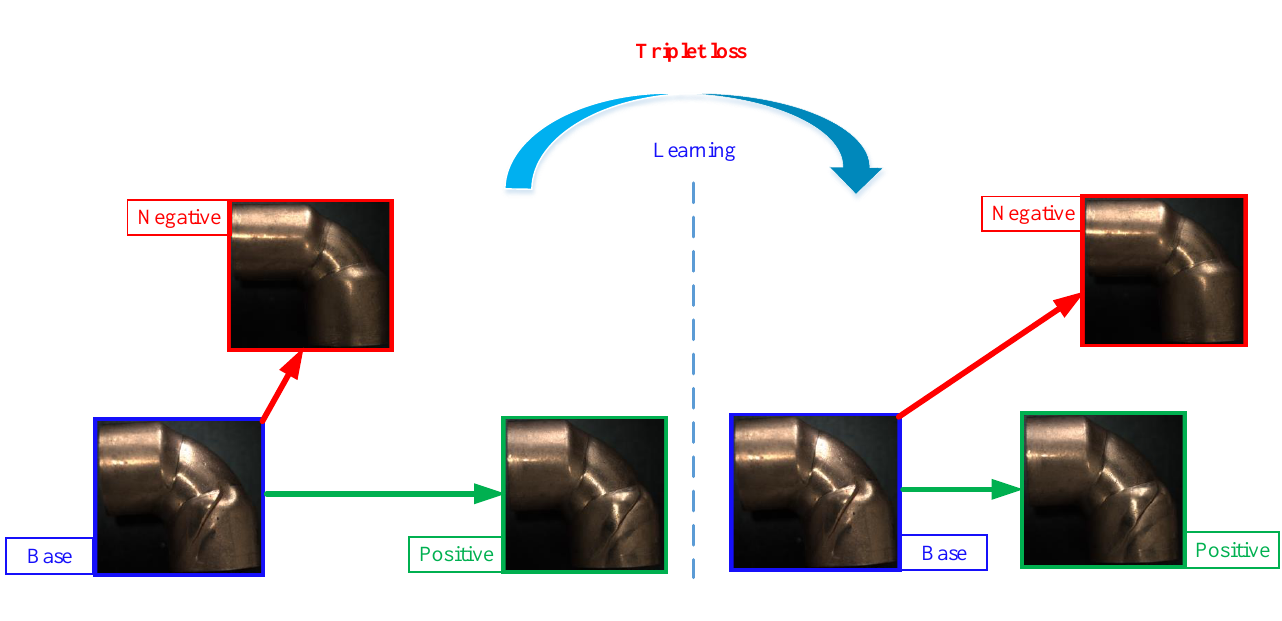
Figure 4. The main idea of learning with triplet loss. Triplet loss learns to minimize the distance between positive samples and the base, maximizing the distance between negative samples with the anchor. ( a ) Samples before triplet loss learning. ( b ) Samples after triplet loss